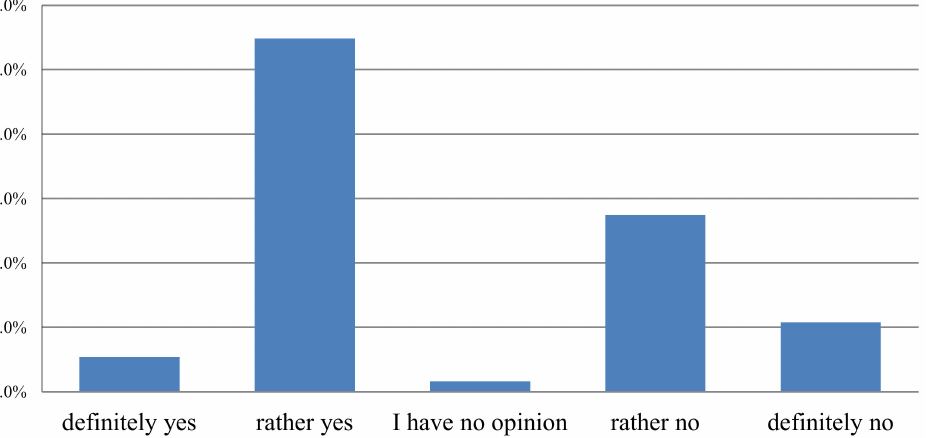
Figure 2. Opportunities to generate and implement new solutions in the company. Source: Own